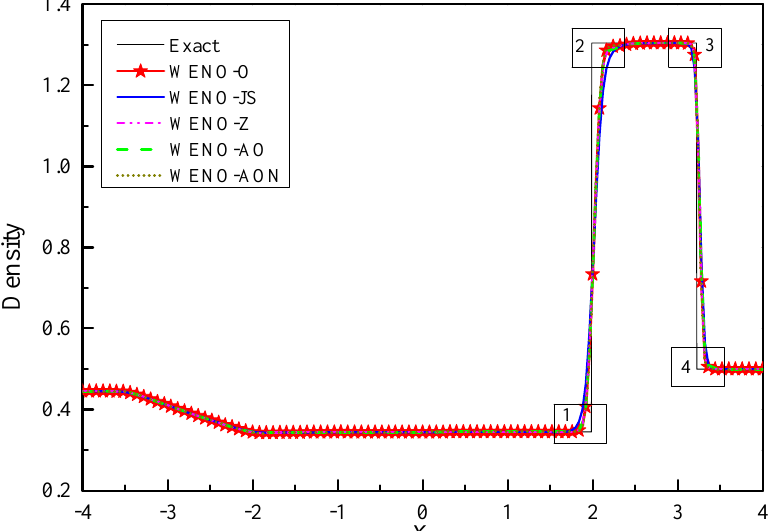
Figure 12. Numerical results of Lax’s problem of Example 4 (Section 6.2.1) for density field at time t = 1.3, CFL = 0.95 with 200 cells for the considered WENO